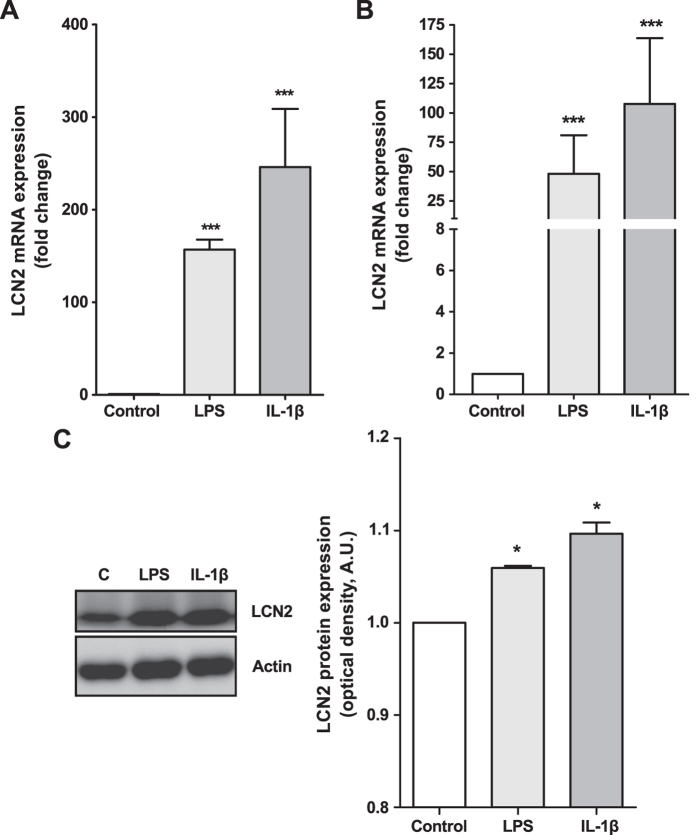
Effect of pro-inflammatory stimuli on LCN2 expression in murine and human osteoblasts.Non-differentiated MC3T3 cells were stimulated with 1 μg/ml LPS or 1 ng/ml IL-1β for 48 h to evaluate LCN2 gene expression (A). Human osteoblasts were grown until confluence and, after overnight culture in 1% FBS, cells were stimulated with 1 μg/ml LPS or 1 ng/ml IL-1β for 48 h. LCN2 mRNA expression was measured by real-time PCR (B). LCN2 protein expression was determined by western blot analysis and quantified by densitometry. Cropped images of the blots are shown. Full-length blots are presented in Supplementary Fig. 1. Gels were run under the same experimental conditions. (C). The results are presented as the mean ± SEM of at least four independent experiments and expressed as the fold-change over the control (*p < 0.05, ***p < 0.001).